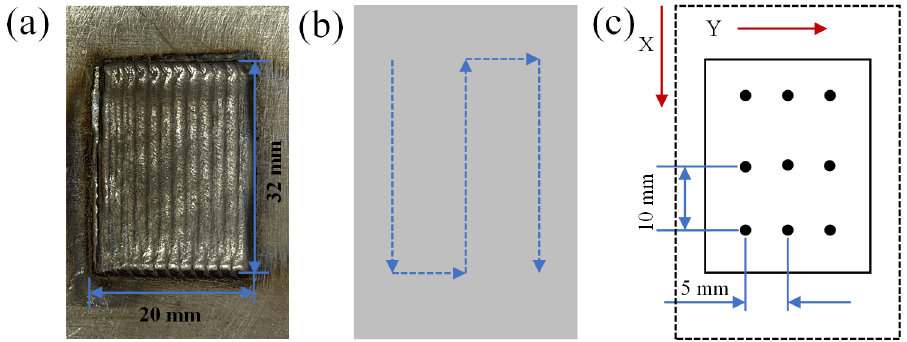
Figure 3. ( a ) Top view of the laser cladding coating; ( b ) laser scanning path; ( c ) residual stress testing points. Table 2. The process parameters used in preparation of coatings.